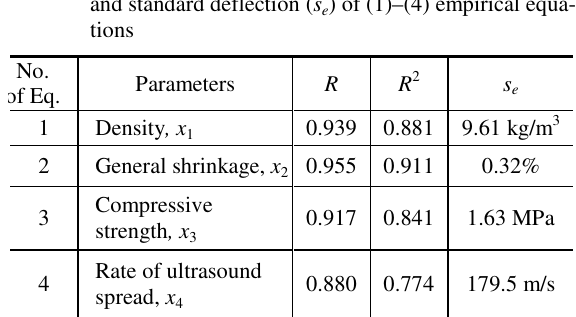
Table 6. The coefficients of correlation ( R ), determination ( R 2 )